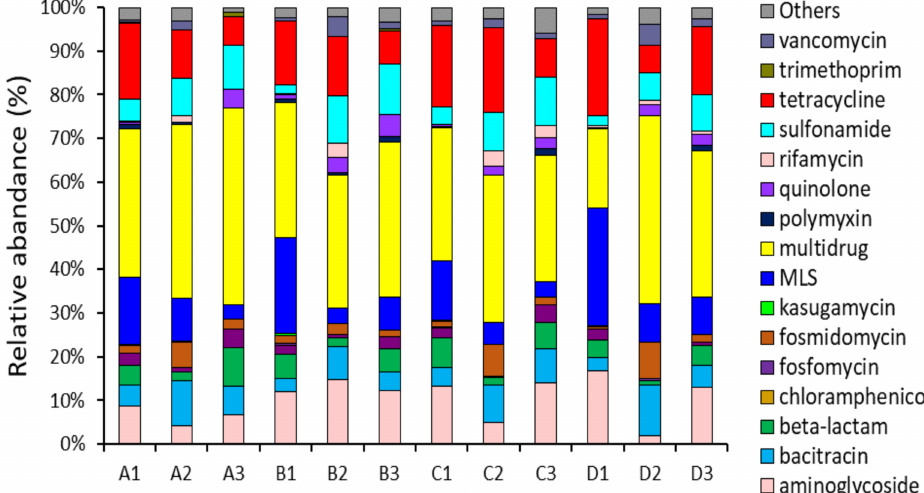
Figure 1. Relative abundance of antibiotic resistance gene (ARG) types in the small (A, B) and large (C, D) WWTP samples. A1, B1, and C1 indicate influent samples, A2, B2, and C2 indicate activated sludge samples, and A3, B3, C3 indicate effluent